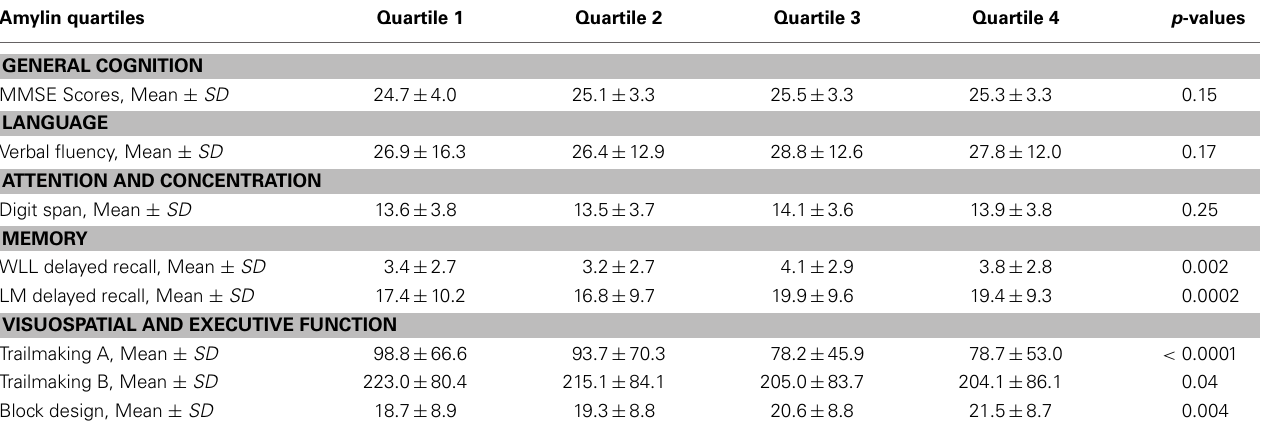
Table 2 | Comparisons of functions in cognitive domains across amylin